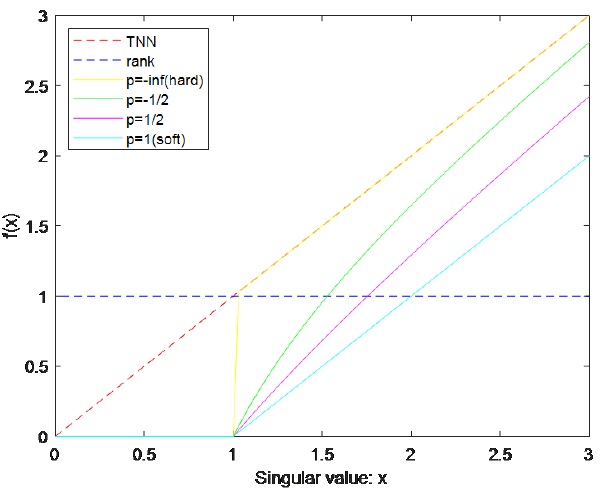
Figure 1. Approximation of rank from p -TNN, TNN, and tensor average rank acting on the frontal slice, respectively, where the x-axis is the singular value, while the y-axis denotes the results obtained by p -TNN, TNN, and tensor average